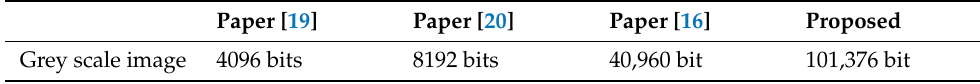
Table 5. Capacity comparison with existing methods.